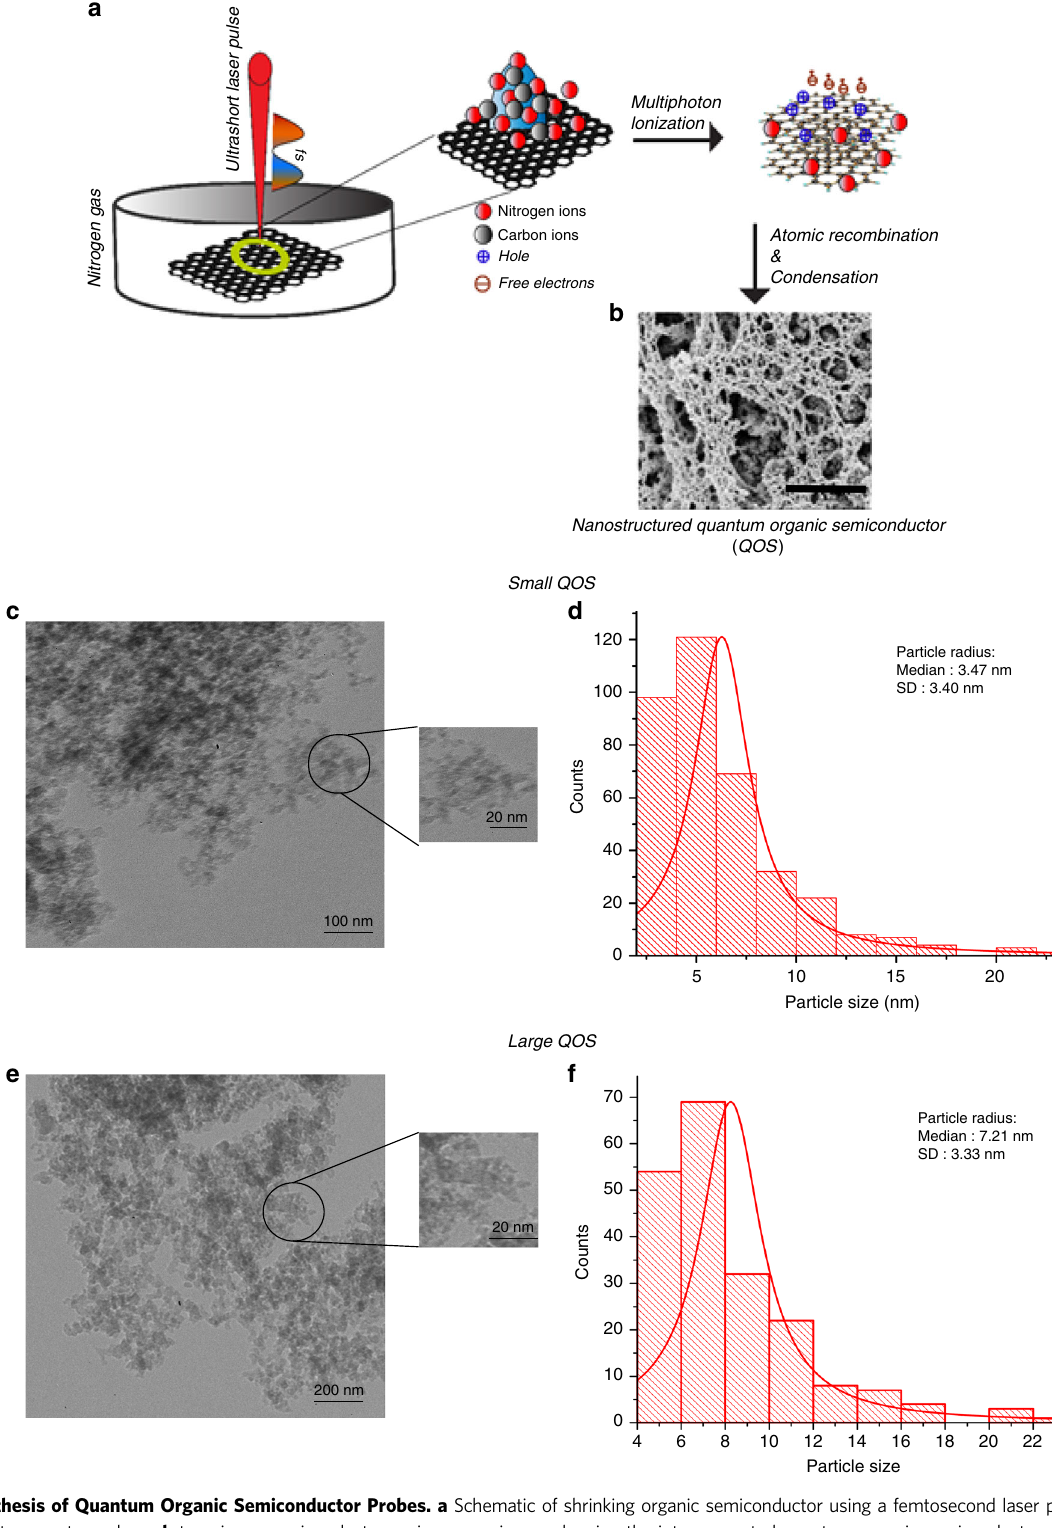
Fig. 1 Synthesis of Quantum Organic Semiconductor Probes. a Schematic of shrinking organic semiconductor using a femtosecond laser pulse under low- pressure nitrogen atmosphere, b top-view scanning electron microscope image showing the interconnected quantum organic semiconductor probes, c , e morphology of Small QOS and Large QOS respectively, d , f Size distribution of Small QOS and Large QOS respectively showing the normal distribution of